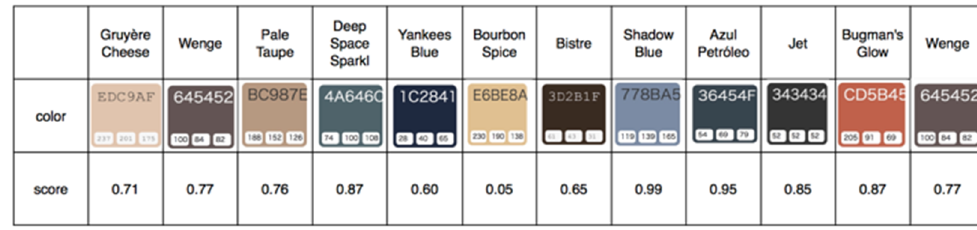
(cid:0) (cid:1) x i